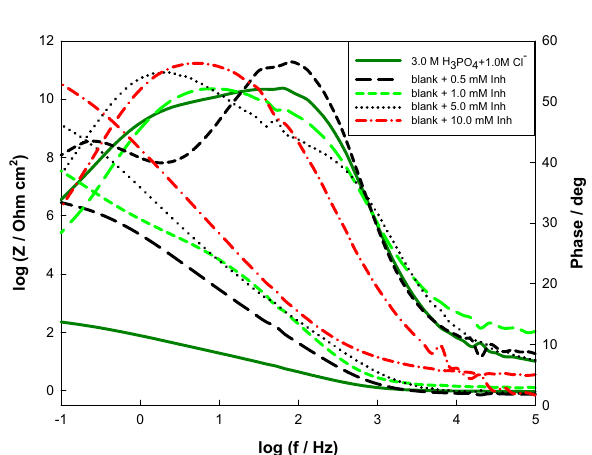
Table 5. Impedance parameters of Mo electrode as a function of NaCl concentration in 3.0 M phosphoric acid at 298 K.